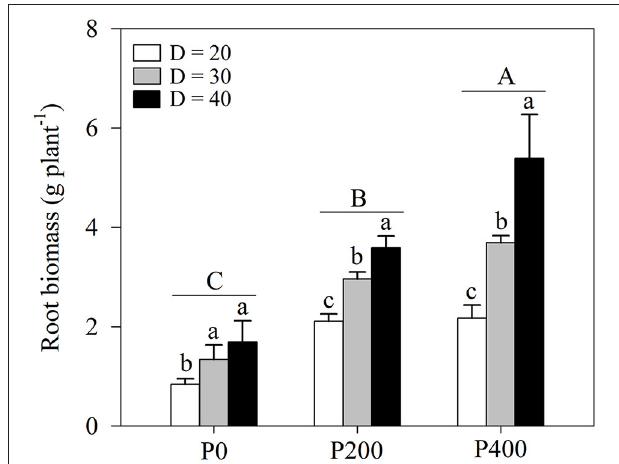
FIGURE 2 | Root biomass under different phosphorous (P) supply gradients and space availability conditions. Each value represents the mean of four replicates ( + SD). Different lower-case letters indicate a significant difference among different space availability levels, and different capital letters indicate a significant among different P levels ( P < 0.05). P0, 0mg P kg − 1 soil; P200, 200mg P kg − 1 soil; and P400, 400mg P kg − 1 soil; D = 20, D = 30, and D = 40 represent diameter of pot is 20, 30, and 40cm,